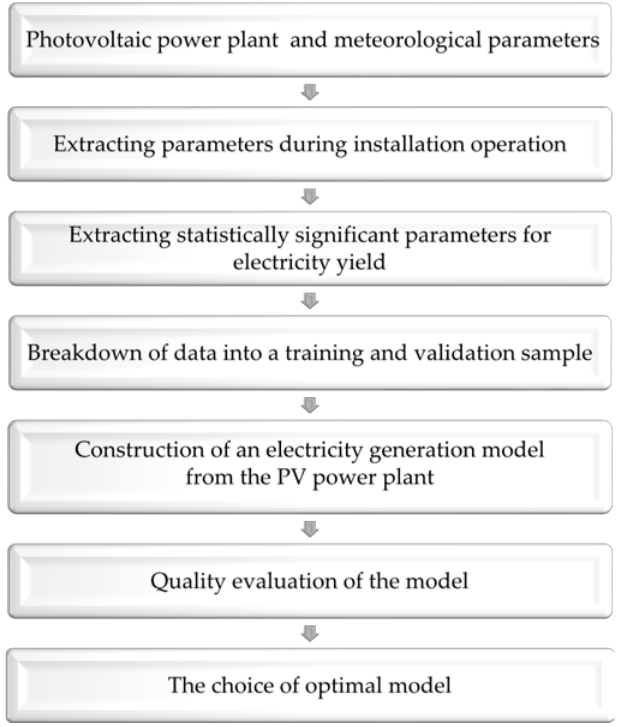
Figure 6. Block diagram of the model for estimating the energy yield from the photovoltaic power plant.